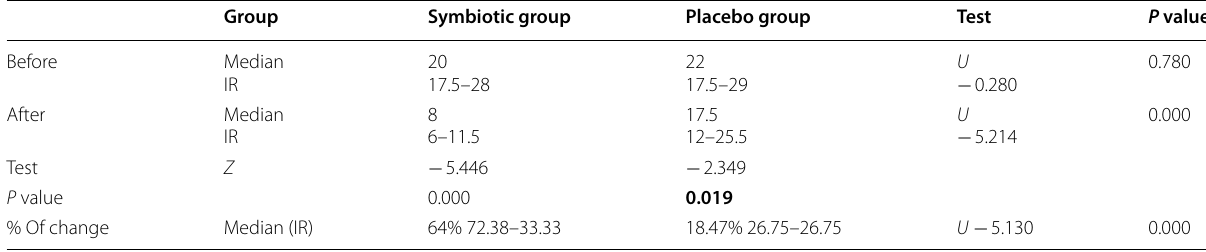
Table 3 Comparison of change in IS between both